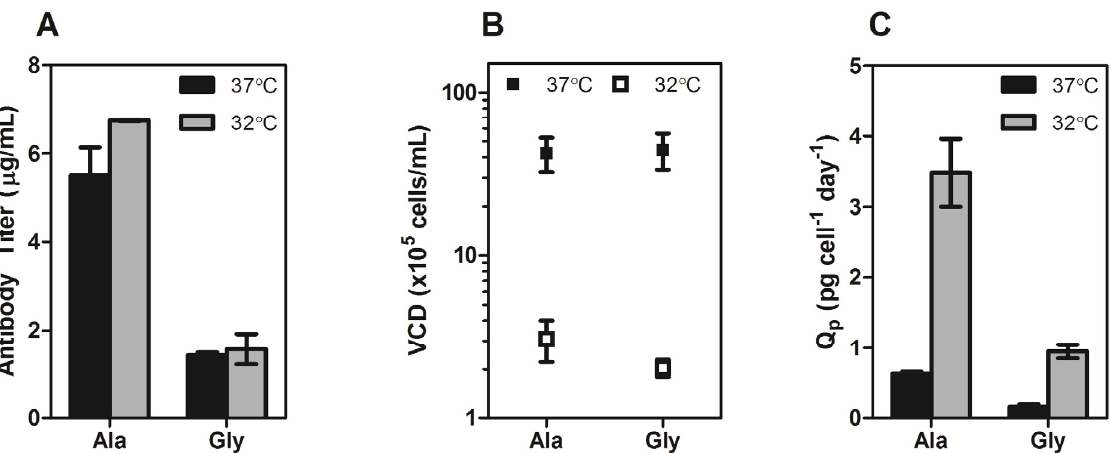
Figure 2. ( A ) Transient expression titers of Ala and Gly antibodies after a 5-day incubation at 37 °C (black bars) or 32 °C (gray bars). ( B ) The viable cell density (VCD) of the Ala and Gly cultures at 37 °C ( ■ ) and 32 °C ( □ ). ( C ) Specific productivities of Ala and Gly antibodies at 37 °C (black bars) or 32 °C (gray bars). The error bars represent ± 1 standard deviation from the mean of experimental replicates (n =